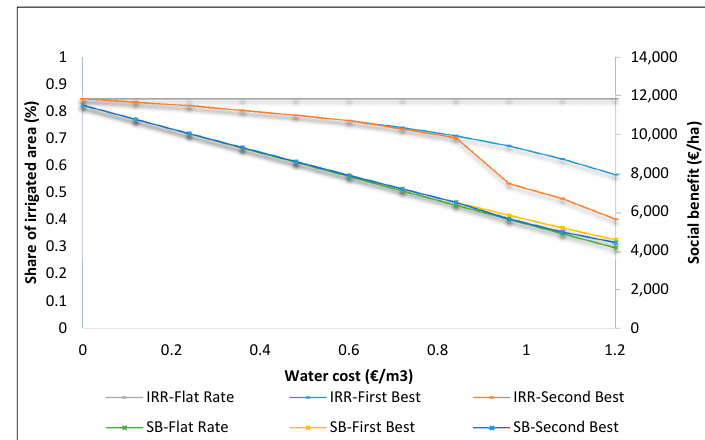
Figure 1. The IRR ‐ Flat Rate, IRR ‐ First Best, and IRR ‐ Second Best curves illustrate the trend of the Figure 1. The IRR-Flat Rate, IRR-First Best, and IRR-Second Best curves illustrate the trend of the share share of irrigated area. The SB ‐ Flat Rate, SB ‐ First Best, and SB ‐ Second Best curves illustrate the trend of irrigated area. The SB-Flat Rate, SB-First Best, and SB-Second Best curves illustrate the trend of the social benefit considering three water pricing scenarios, as the water cost increases. IRR, irrigated share provided as averages across farms; SB, social